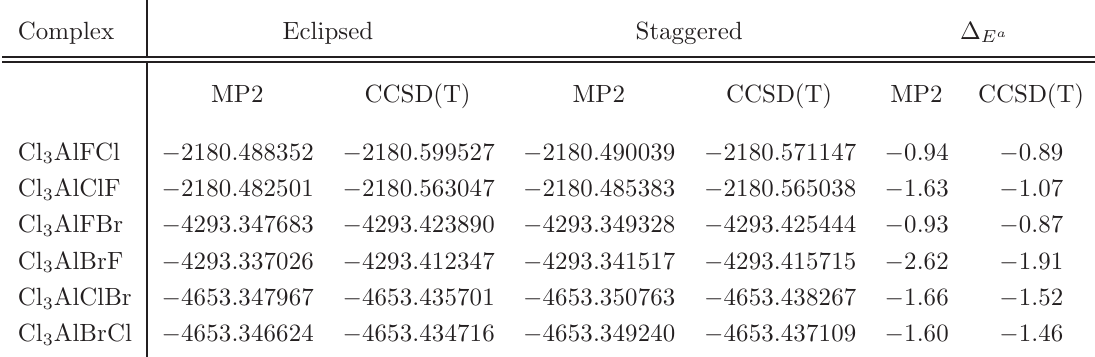
Table 5 MP2 and CCSD(T) total energies E T (a.u.) and relative energies Δ E (kcal/mol) (between the two conformations) of the Cl (X = Y = F, Cl, and